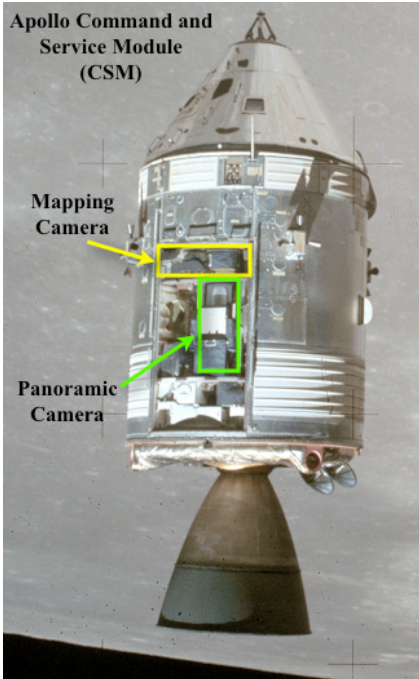
Figure 1: Apollo 15 Command and Service Module with Lunar Mapping Camera System and Panoramic Camera in the Scientific Instrument Module (from NASA image